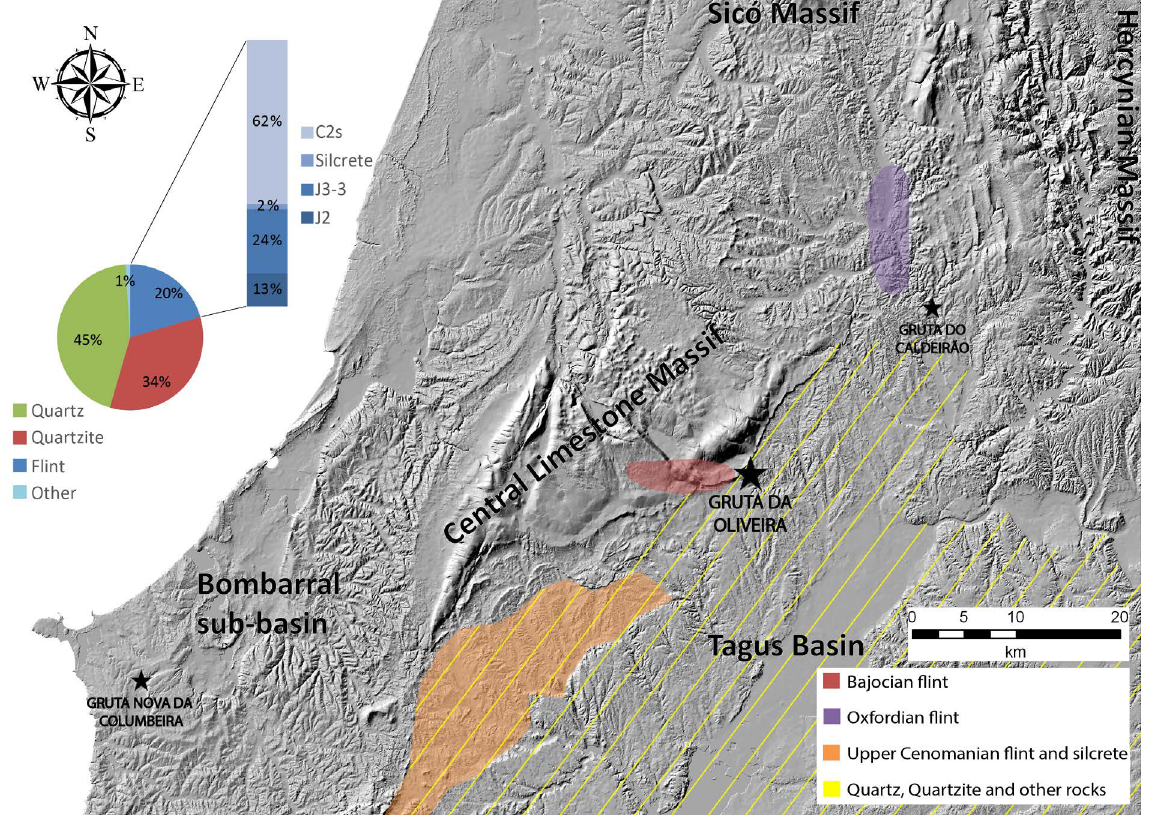
Figure 10. Regional raw material sources, and raw material percentages in layer 14 of Gruta da Oliveira. In the overall pie chart, the “other” category includes limestone, rock crystal, lydite, and igneous